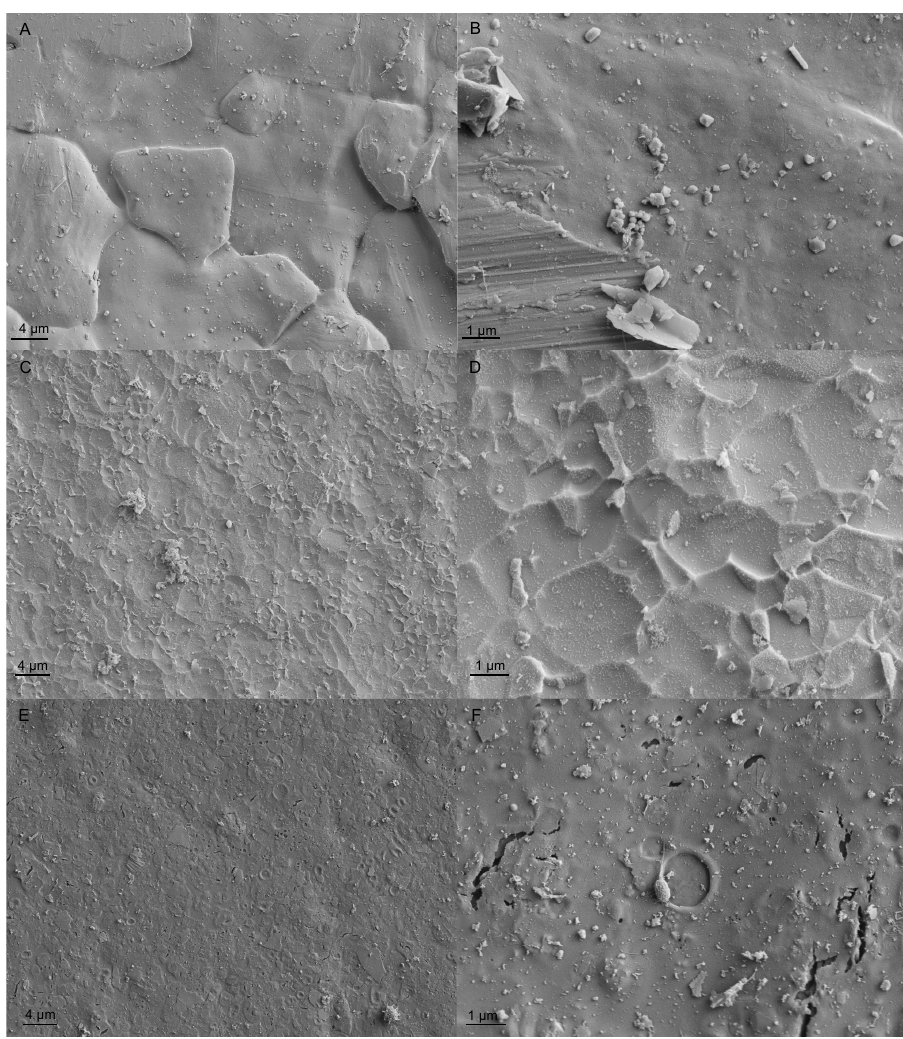
Figure 4. SEM images, showing the surface of coupons from the chlorinated system after three months of exposure. ( A , B ) SMO254; ( C , D ) Ti alloy; ( E , F ) Inerta160.